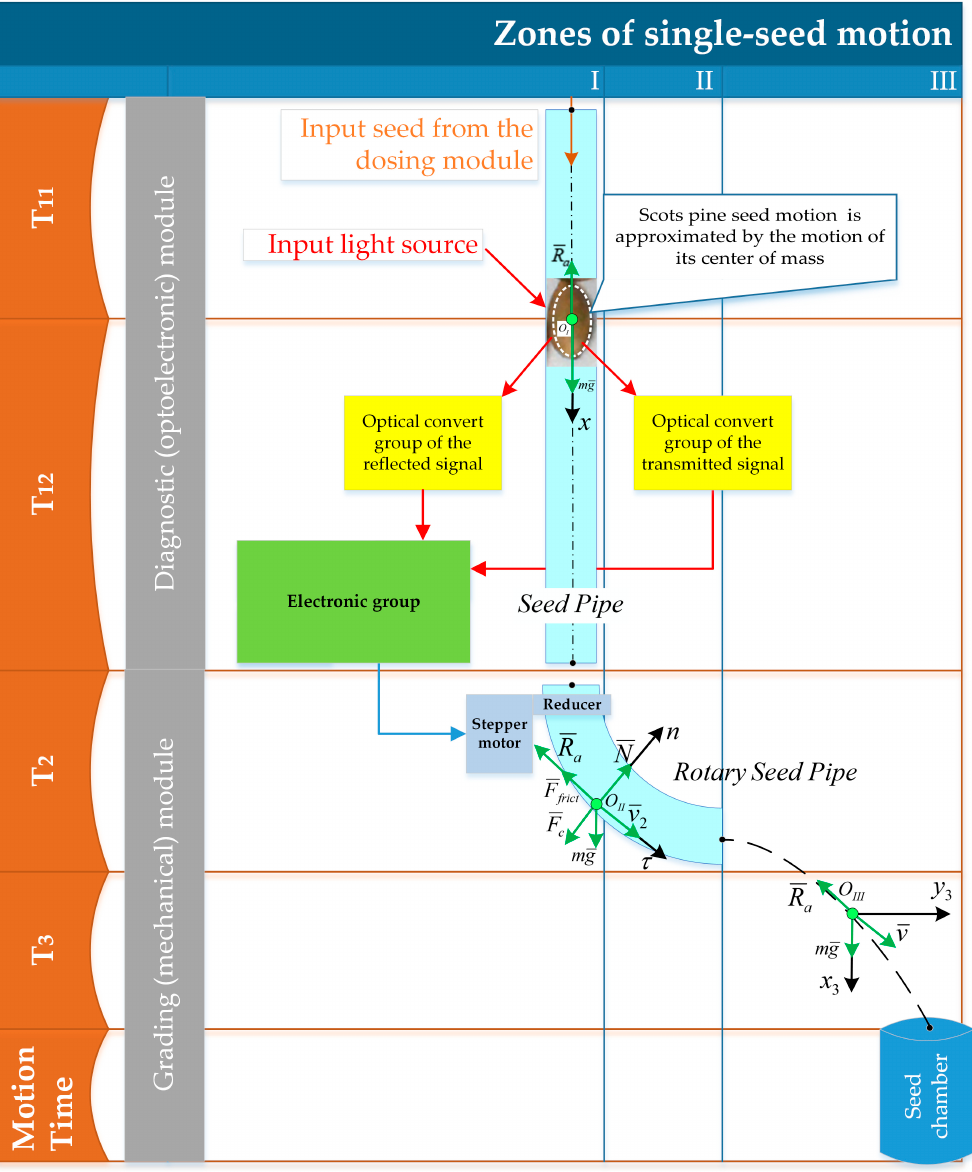
Figure 1. Motion diagram of a single Scots pine seed inside the seed pipe of an optoelectronic